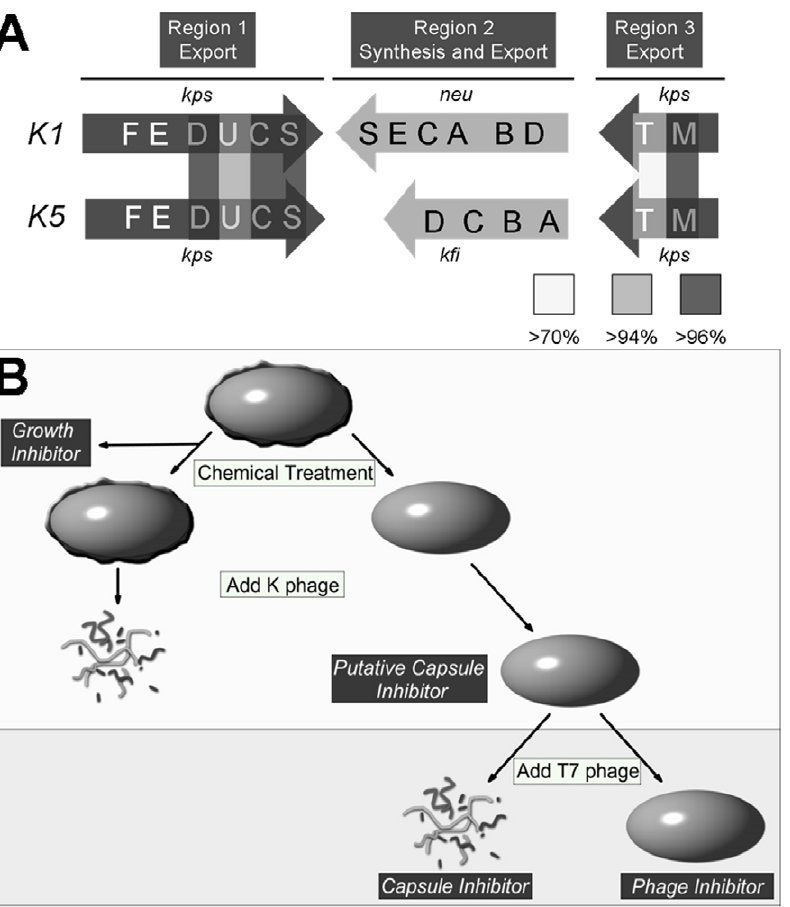
Figure 1. Group 2 capsules and overview of screening strategy to identify capsule biogenesis inhibitors. ( A ) Organization of the genomic region encoding for major K capsule synthesis and assembly products . The Group 2 capsules are encoded from similar loci. The SYNTHESIS gene products derive the primary monosaccharides necessary for capsule and render the monosaccharides competent for polymerization. The ASSEMBLY and EXPORT products co-assemble to polymerize the capsule and transport it out of the bacterium where it envelops the cell. As examples, K1 and K5 capsules differ in Region II gene number and identity. Interconnecting lines indicate degree of amino acid identity between key structural components of capsule biogenesis encoded from Region I and Region III. Thick, thin, and doted lines indicate . 97%, . 94%, and . 70% identity, respectively (further details in Table S1). ( B ) Diagram of high-throughput screen for capsule inhibitors . Wells of a 96-well plate were seeded with a dilution of UPEC K1 strain UTI89. Compounds from the DTP small molecule library were placed in appropriate wells at a final concentration 100 m M. After a short incubation, the K1 capsule specific K1F phage was added to these wells. Growth was monitored and compounds that did not produce an initial growth inhibition but did inhibit phage lysis, suggesting altered capsule biosynthesis or phage inhibition, were further tested. Secondary assays (indicated by shaded block) were conducted using the engineered K-12:K1 strain EV36. T7 phage, inhibited by T7 capsule but genetically similar to K1F phage, was used to infect this strain. Compounds that sensitized cells to T7 phage were classified as having capsule-specific effect(s) and selected for further analysis. Finally, the K-12 strain MG1655, which is readily lysed by T7 phage, was used in a final assay to determine which compounds inhibited phage lysis.